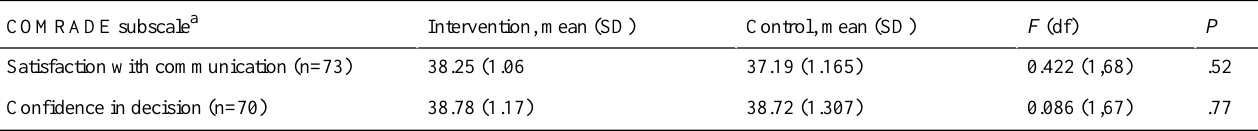
Table 3. Primary outcome data of patients’ perceived involvement in medical decision making at the end of the study using the Combined Outcome Measure for Risk Communication and Treatment Decision-making Effectiveness (COMRADE)